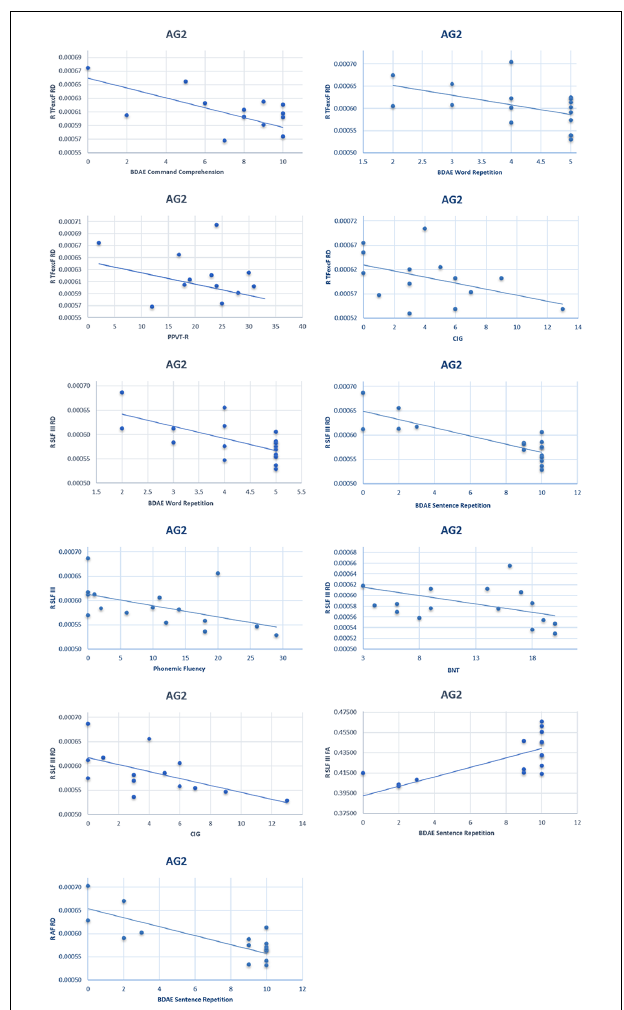
FIGURE 10 | Scatterplots of the significant correlations between language performance and radial diffusivity/fractional anisotropy of the right hemisphere TFexcF, SLF III, and AF in the AG2 subgroup. BDAE: Boston Diagnostic Aphasia Examination; PPVT-R: Peabody Vocabulary Test-Revised; CIG: Comprehension of Instructions Test in Greek; BNT: Boston Naming